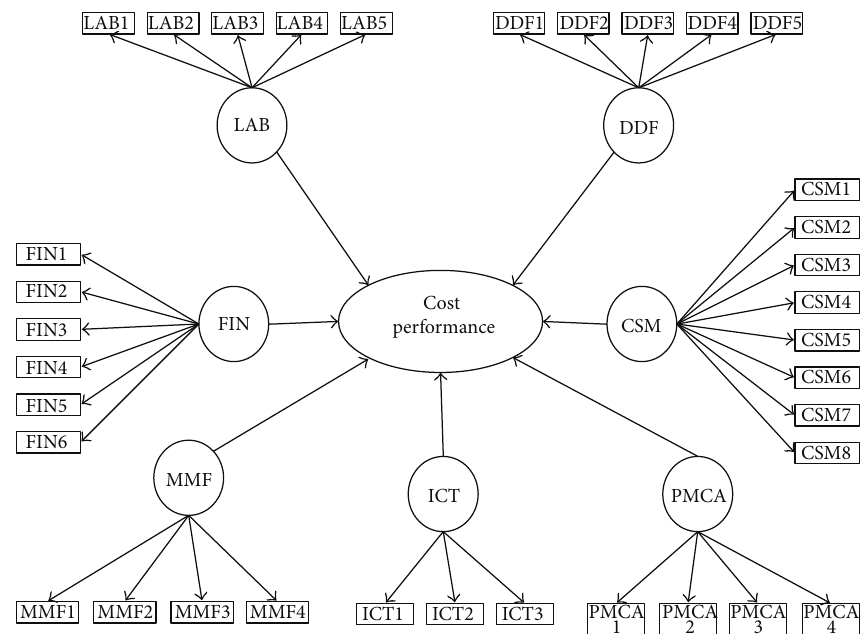
Figure 1: Conceptual model of cost overrun factors.